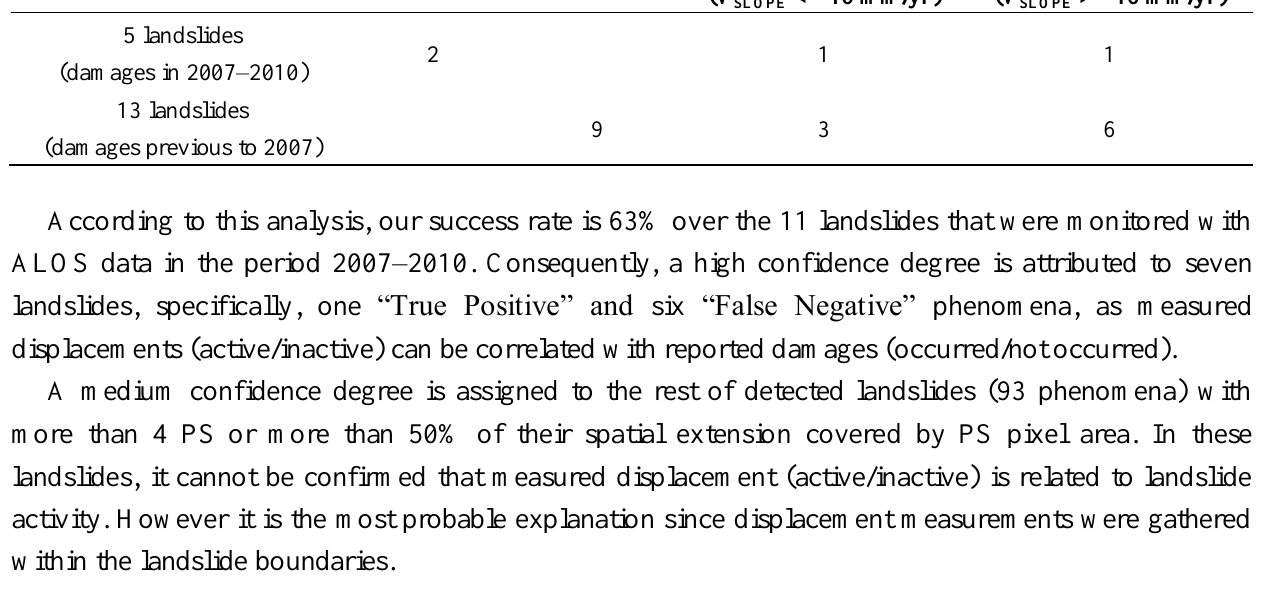
Figure 11. Confidence degree evaluation of Activity